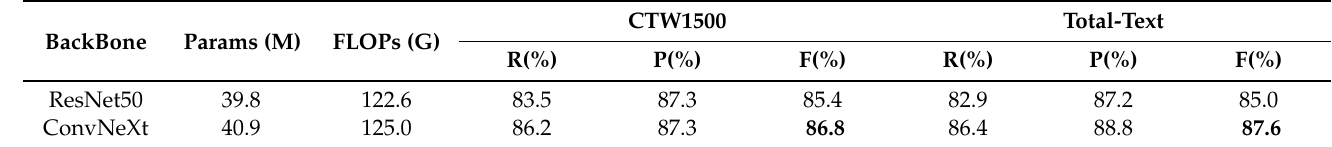
Table 3. Ablation studies: The detection results with different backbone of BSNet on CTW1500 and